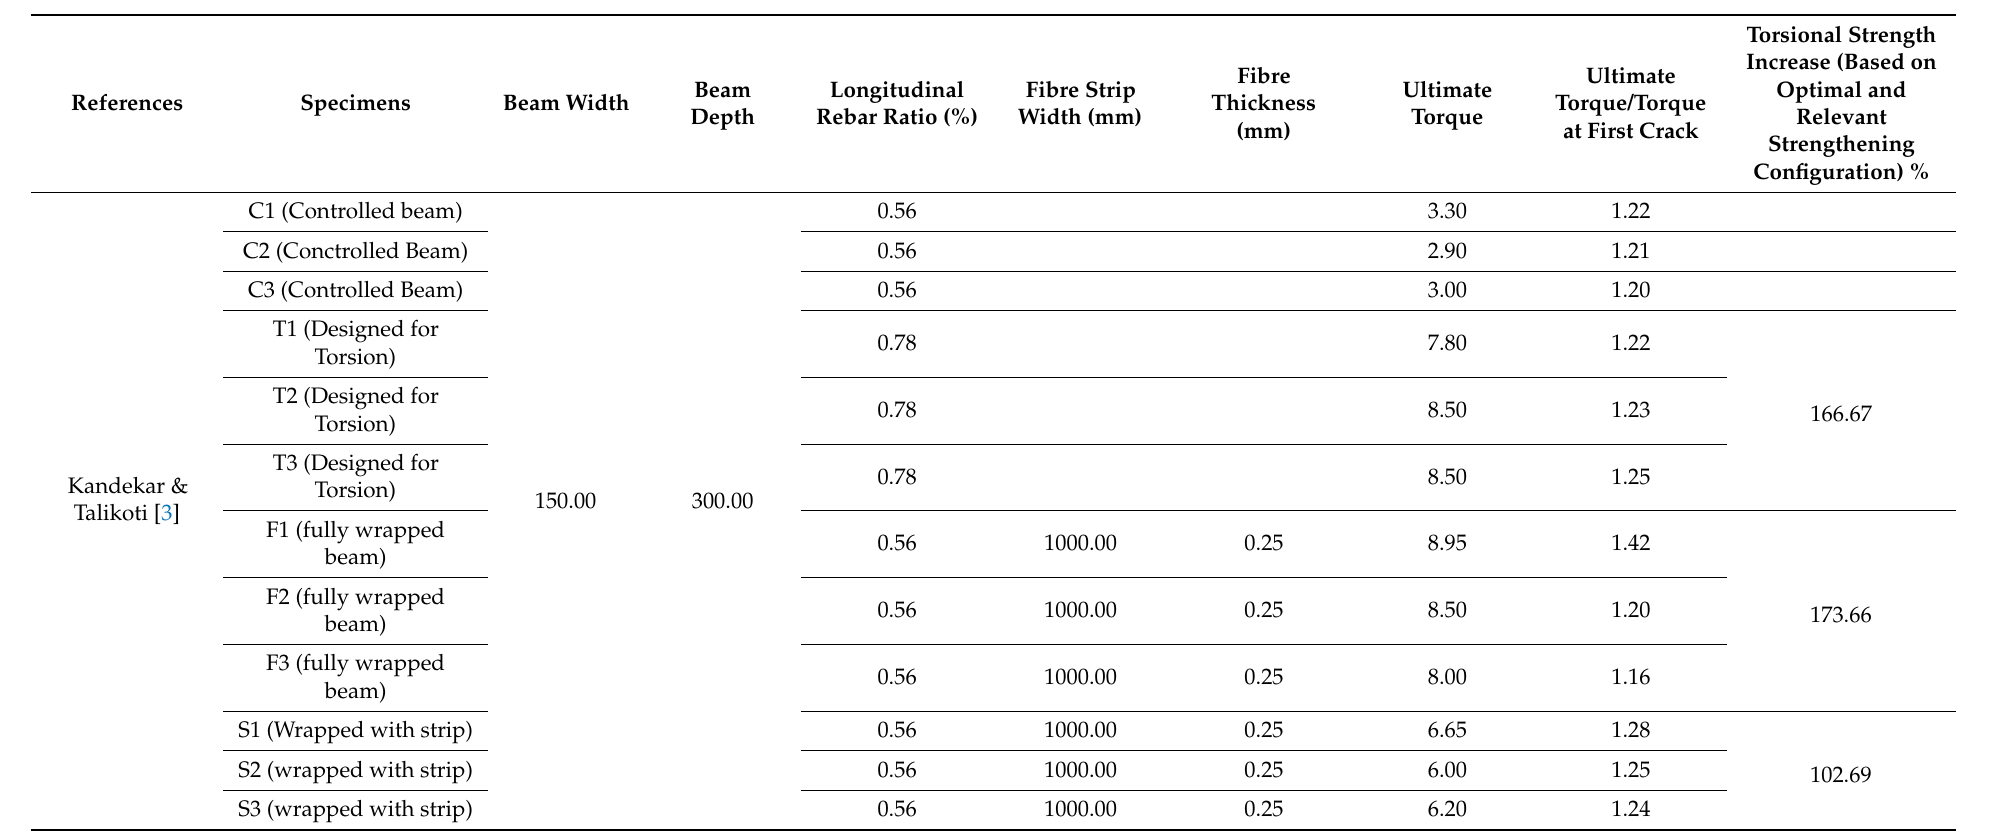
Table 13. Experimental findings on aramid fibre reinforced polymer